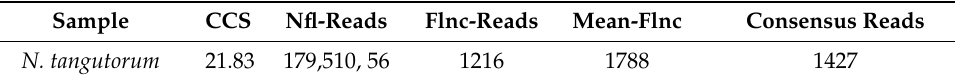
Table 2. CCS quantity statistics data.